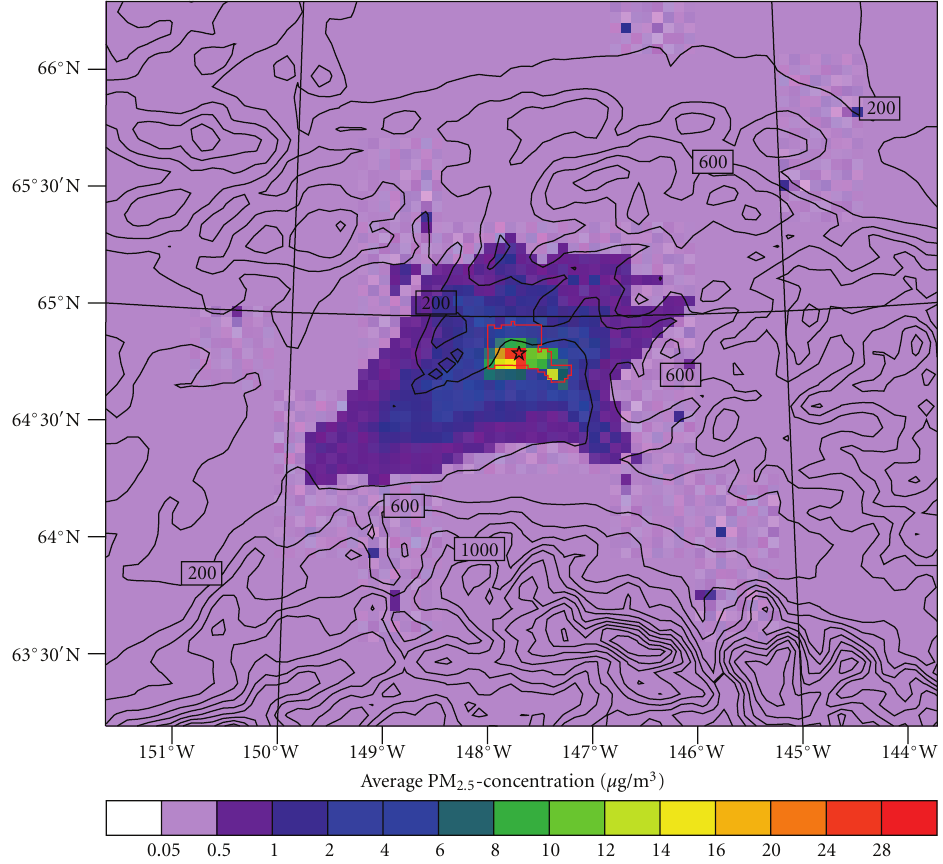
Figure 1: Average PM 2 . 5 concentration in the domain of interest in October to March as obtained in REF with terrain contours overlain. The star and red polygon indicate the grid cell holding the o ffi cial monitoring site and the outline of the nonattainment